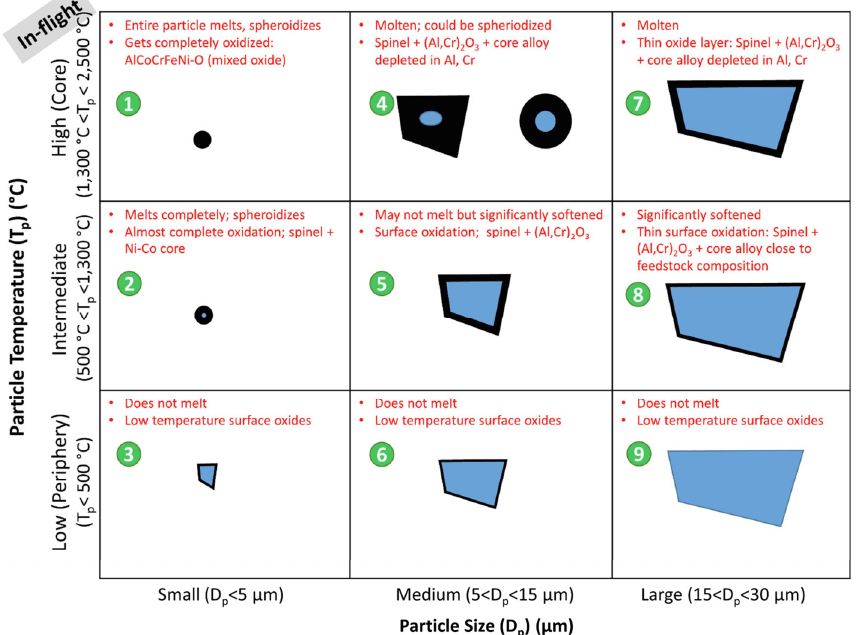
Figure 7. Schematic representation of how varying particle size ranges expose to the temperature and oxidizing atmosphere during in-flight [37].